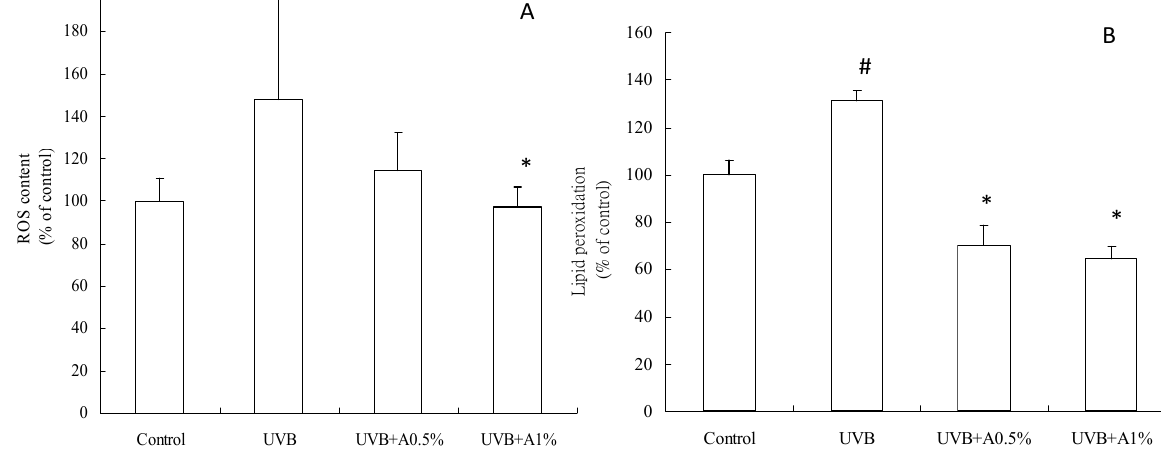
Figure 3. The index of the oxidative stress of skin tissue in UVB-irradiated skin damage in hairless mice: ( A ) ROS content; and ( B ) lipid peroxidation. Values are expressed as the mean ± SD, n = 4; # p < 0.05 vs . control group; * p < 0.05 vs . UVB-irradiated